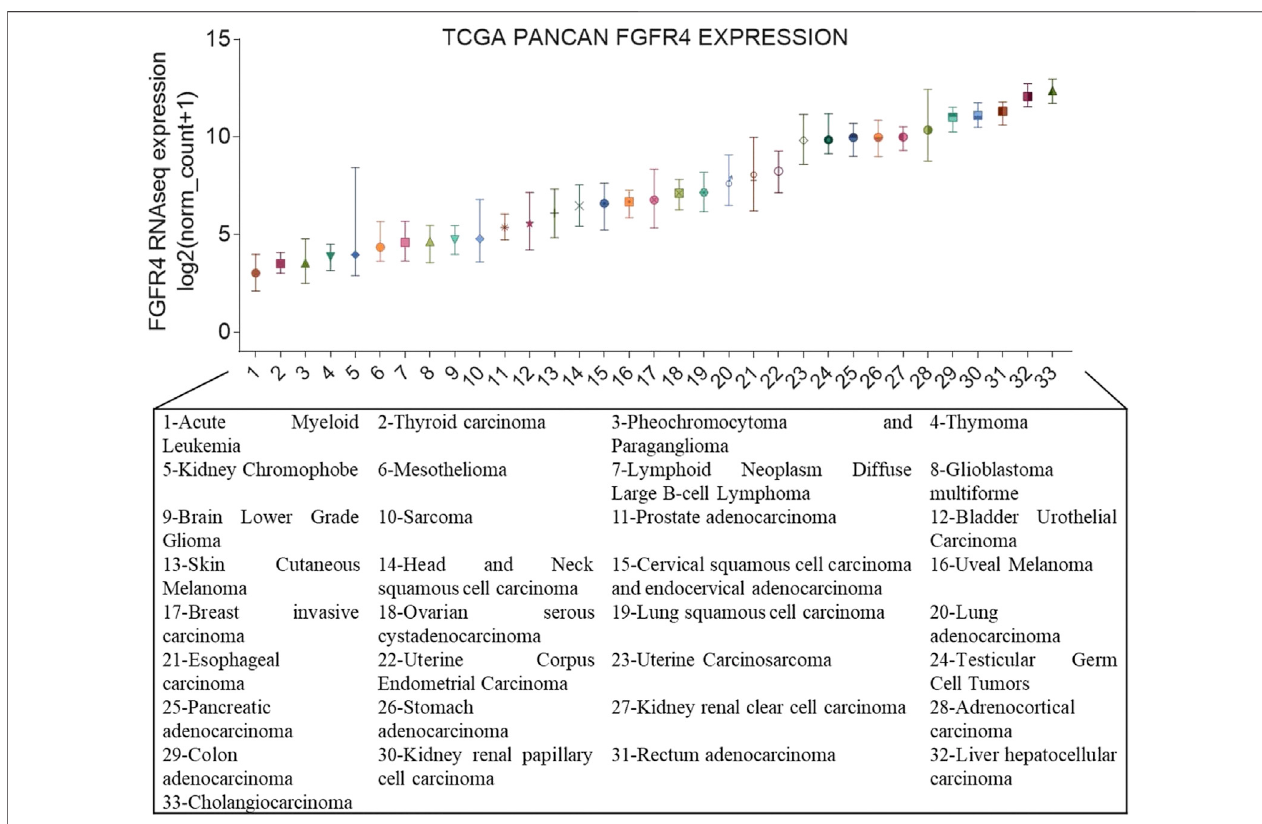
FIGURE 1 | FGFR4 gene expression in cancer. Expression of FGFR4 in different cancer types from The Cancer Genome Atlas (TCGA). On the x -axis are the different cancer types in TCGA, and the y -axis depicts gene expression RNAseq of FGFR4 (IlluminaHiSeq), unit: log2 (norm_count+1).